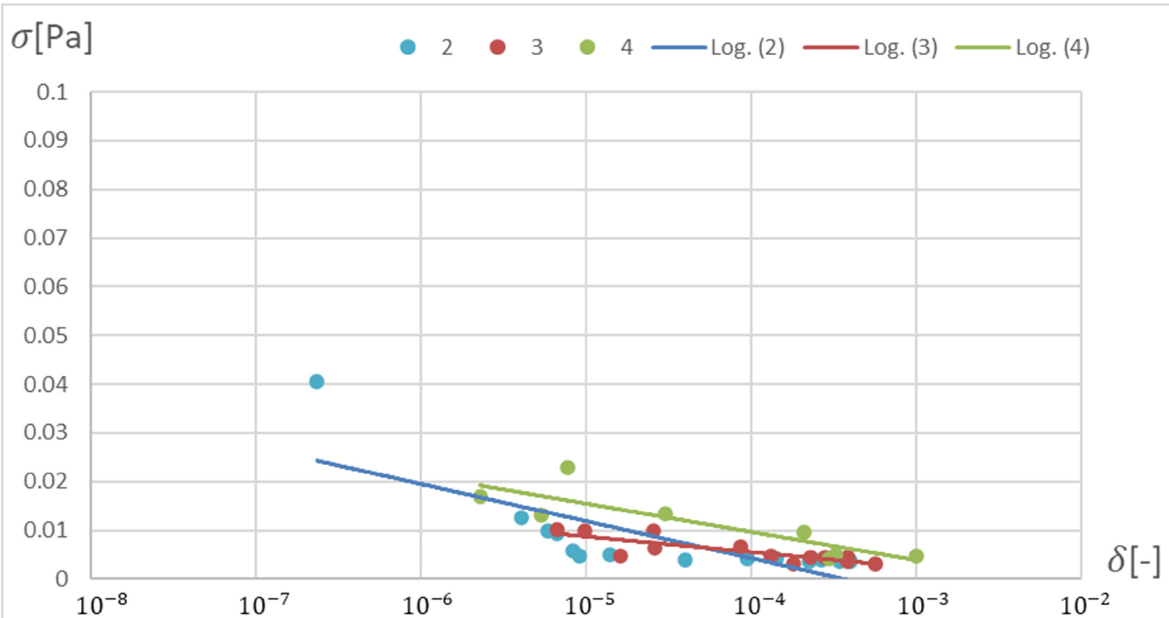
Figure 20. Pareto front depending on the number of neurons in the hidden layer with trend lines marked. Network trained with the SCG method. The determination coefficient ( R 2 ) for the SCG and RPROP algorithm with one hidden layer and from 2 to 4 neurons for the database ± 5% was also compared. Figures 22–24 present the training accuracy of selected algorithms for the best-matched neural networks. It is, respectively, R 2 = 0.9978 and R 2 = 0.9725 for the SCG (NN 20-2-1) and RPROP (NN 20-3-1) algorithms. The accuracy of the optimal ANN structure was calculated on the basis of a newly drawn dataset which was not used in the network training